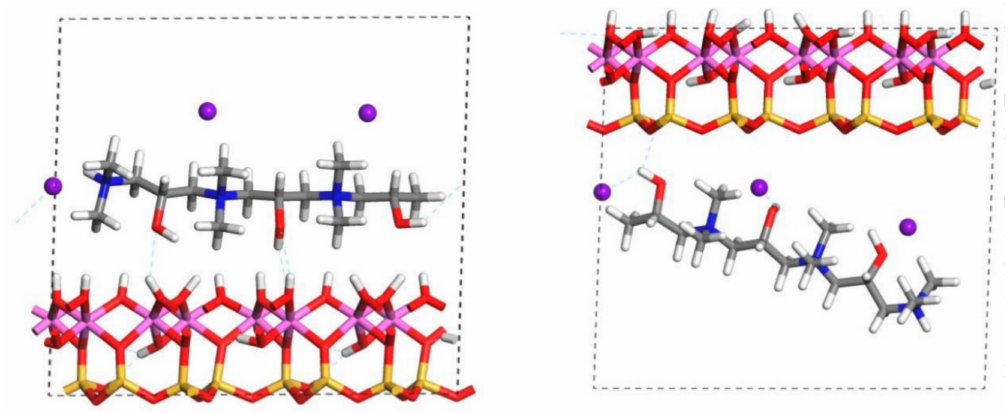
Figure 3. Examples of a trimer of FL22 in Orientation 2—i.e., where the OH-groups point toward the surface (o2) and are either parallel (p) as in the left image, or diagonal (d) to the surface, as in the right image.